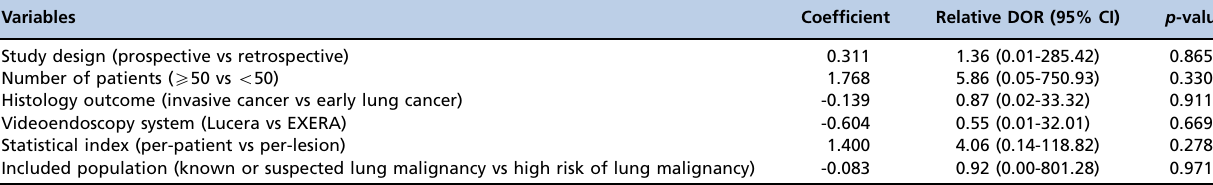
Table 3 - Meta-regression analysis of the potential sources of heterogeneity